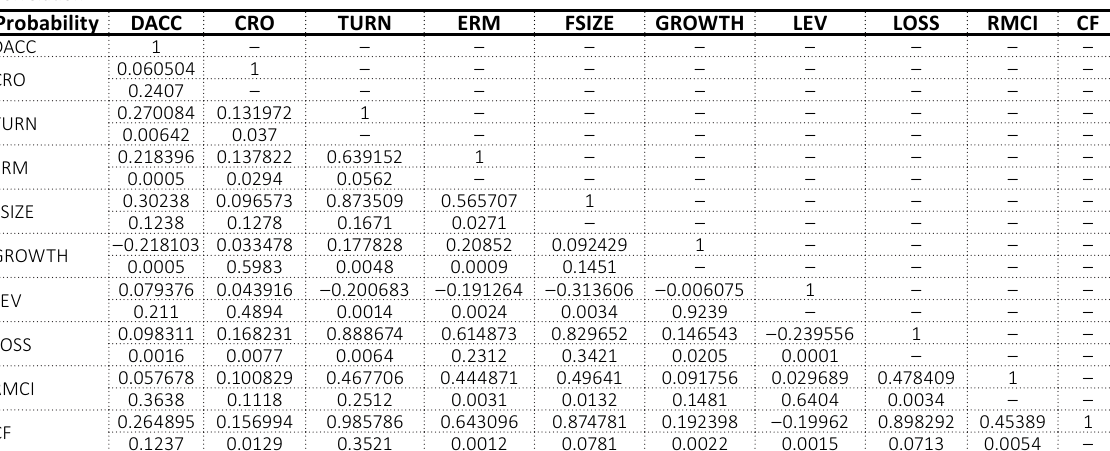
Table 3. Pearson correlation of post-ERM period